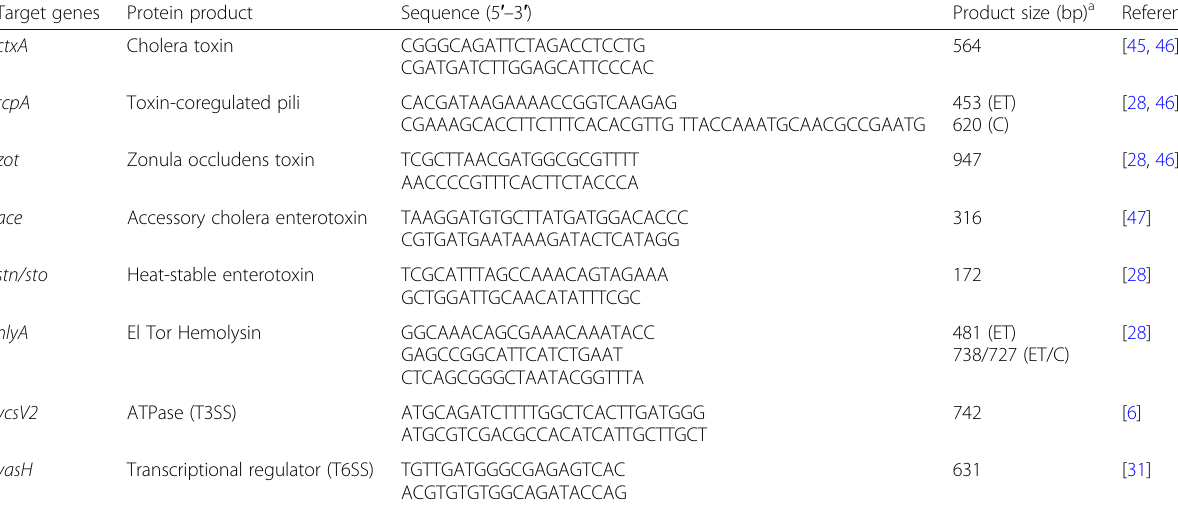
Table 2 PCR primers used in this study Target